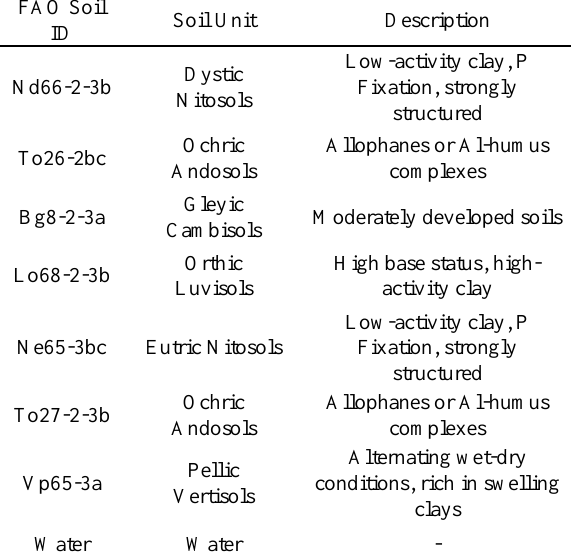
Table 1 . FAO Soil Classification of the study